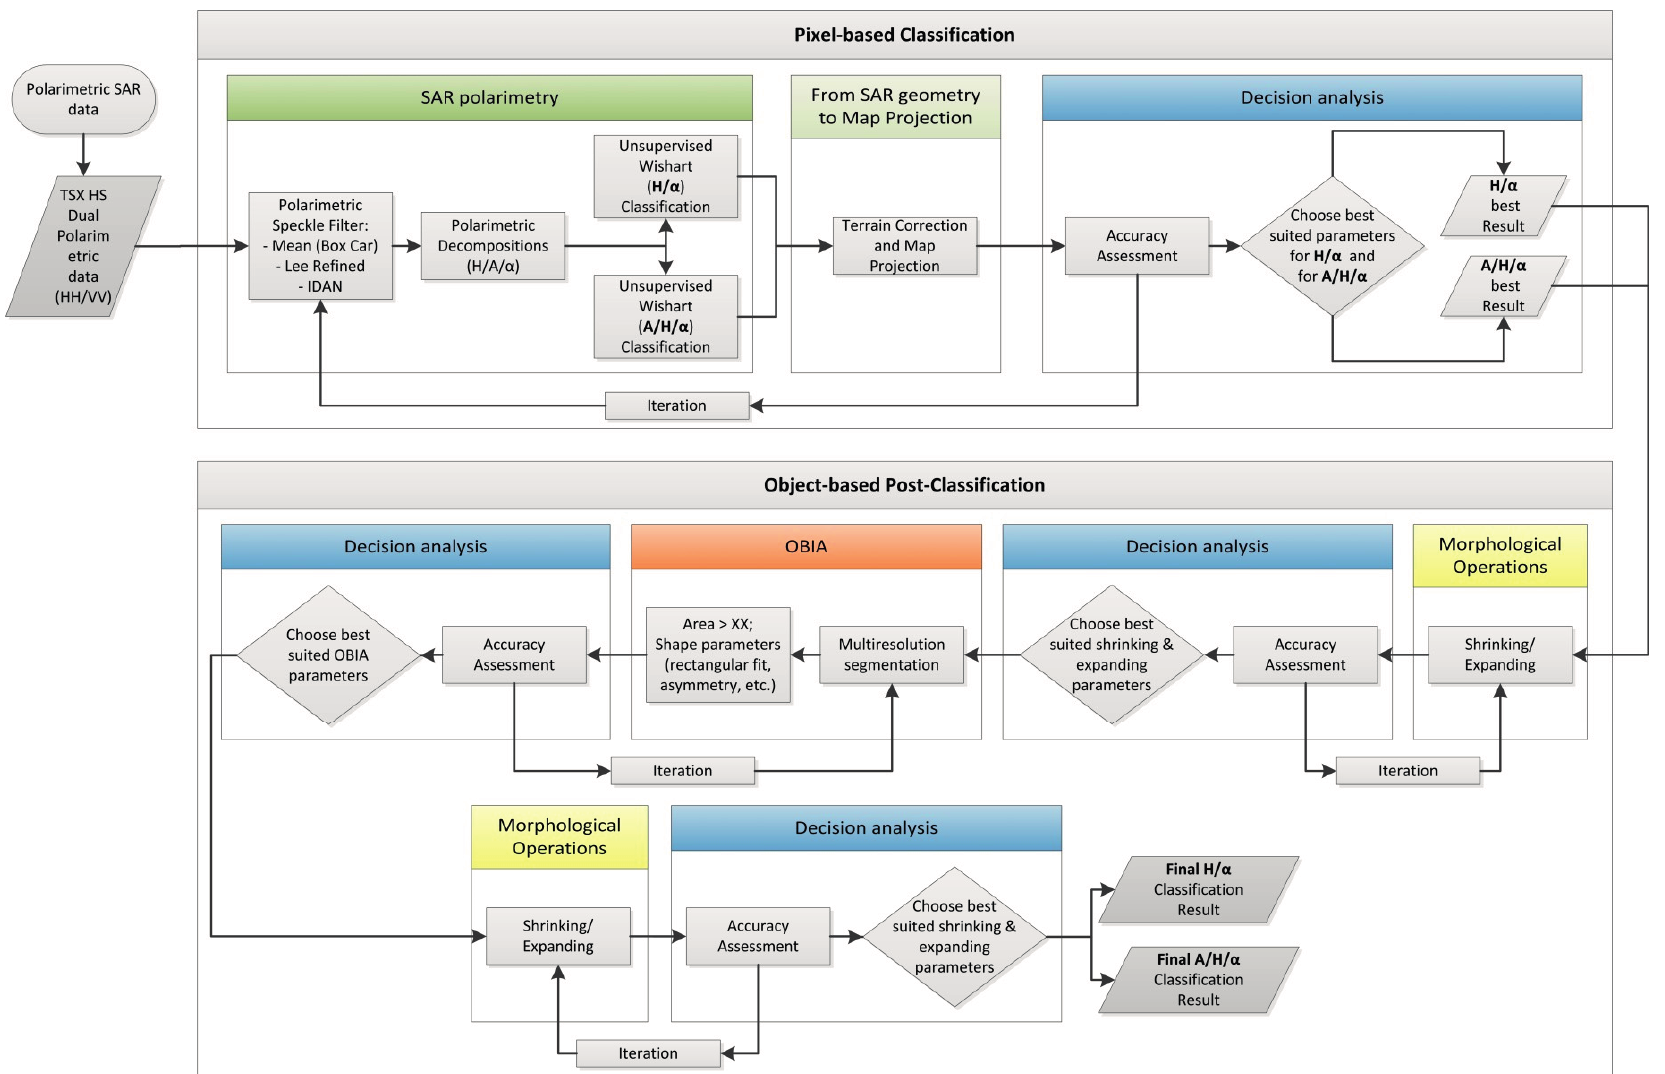
Figure 3. Procedure of the oil well pad feature extraction (iterations only at